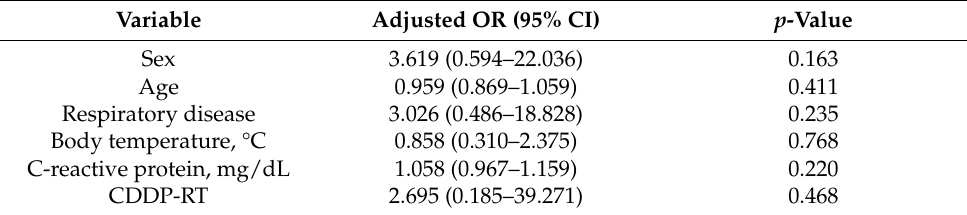
Table 3. Factors independently associated with 30-day mortality due to bloodstream infection in patients with head and neck cancer.